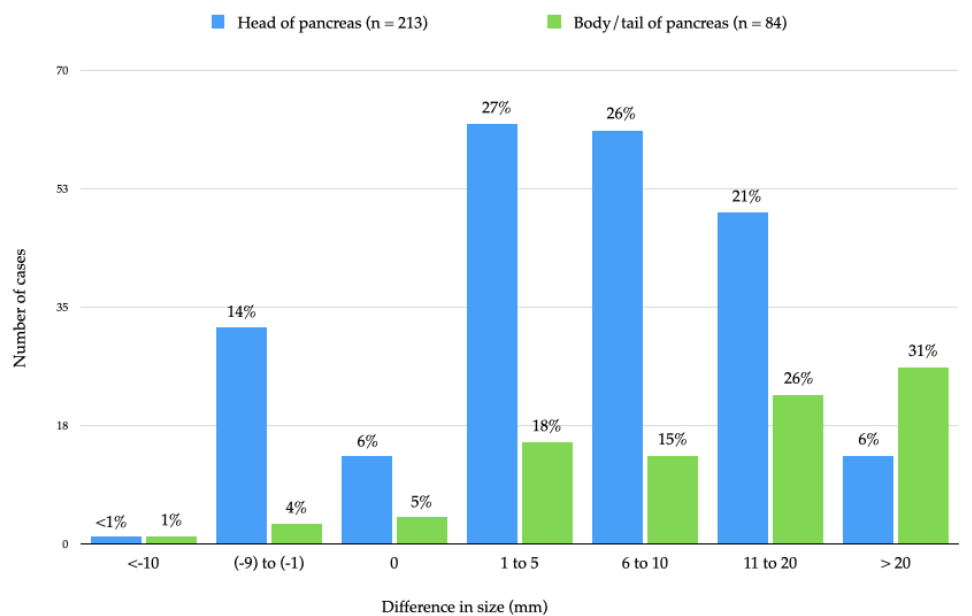
Figure 5. Difference in largest tumour size measured macroscopically in two dimensions (so-called simple approach) versus in three dimensions with microscopic corroboration (so-called compre- hensive approach). The graph shows the number of pancreatic head and body/tail cancers (and percentages, indicated at the top of each bar) for the range of differences in size that were observed between both measurement approaches. Negative values indicate that the size obtained by the comprehensive approach was smaller than the one based on the simple approach.